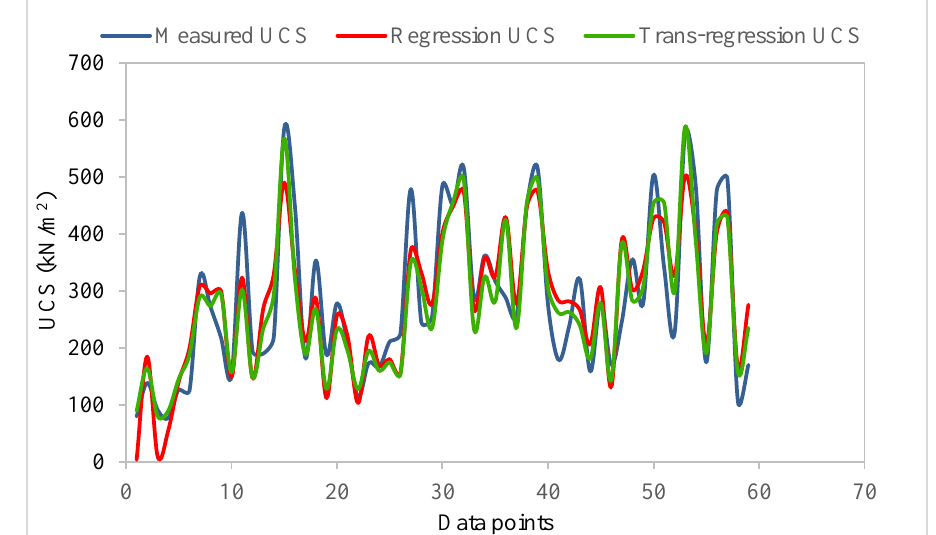
Fig. 5. Trend of the measured and the predicted UCS from the ordinary and the transformed regression